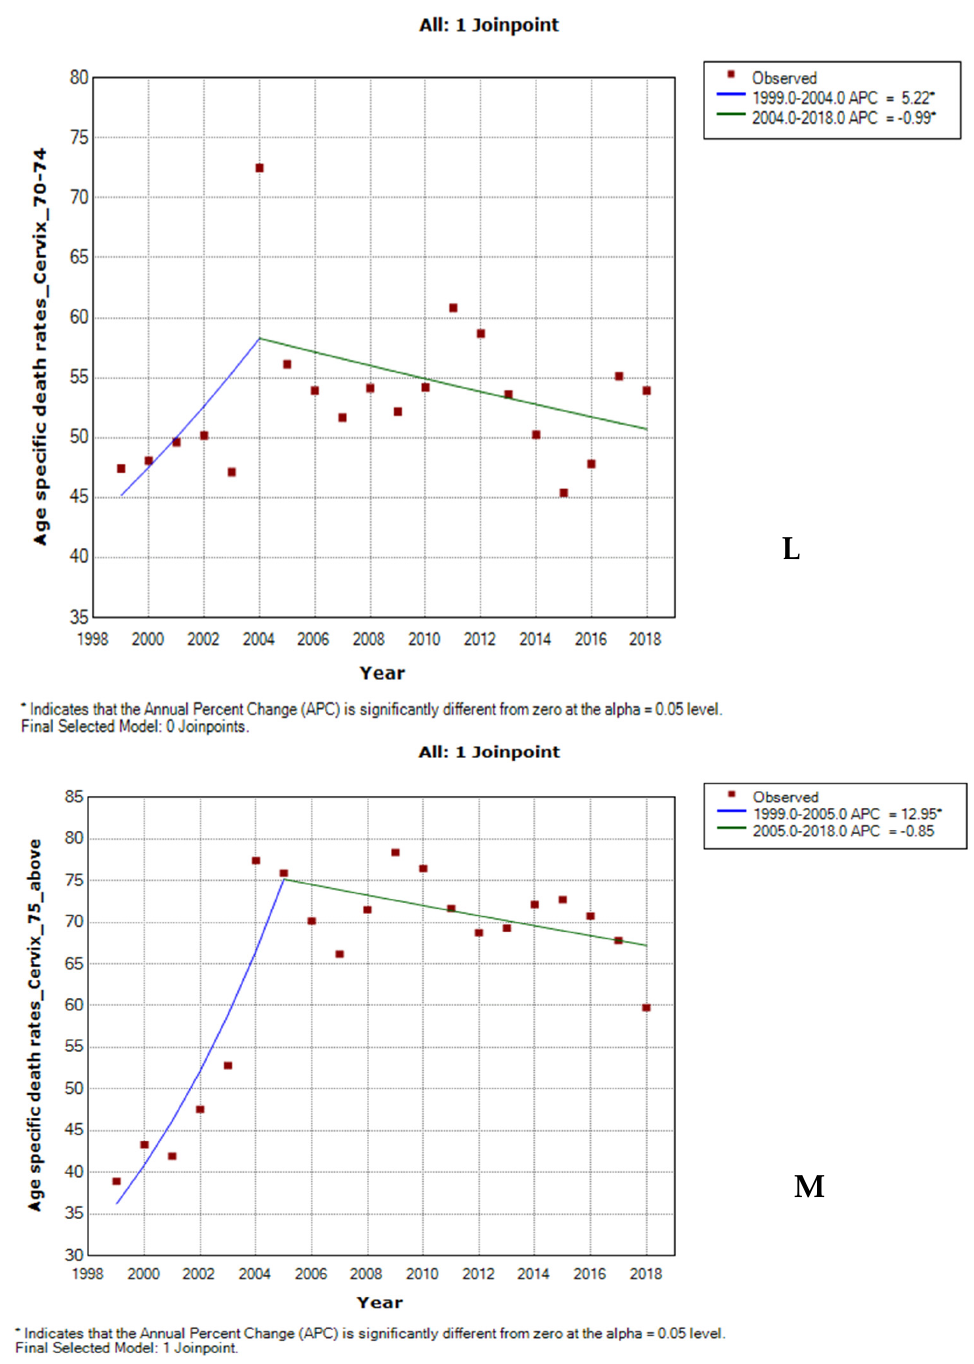
Figure 3. Joinpoint trends of age-specific death rates of cervical cancer in South Africa, 1999–2018.